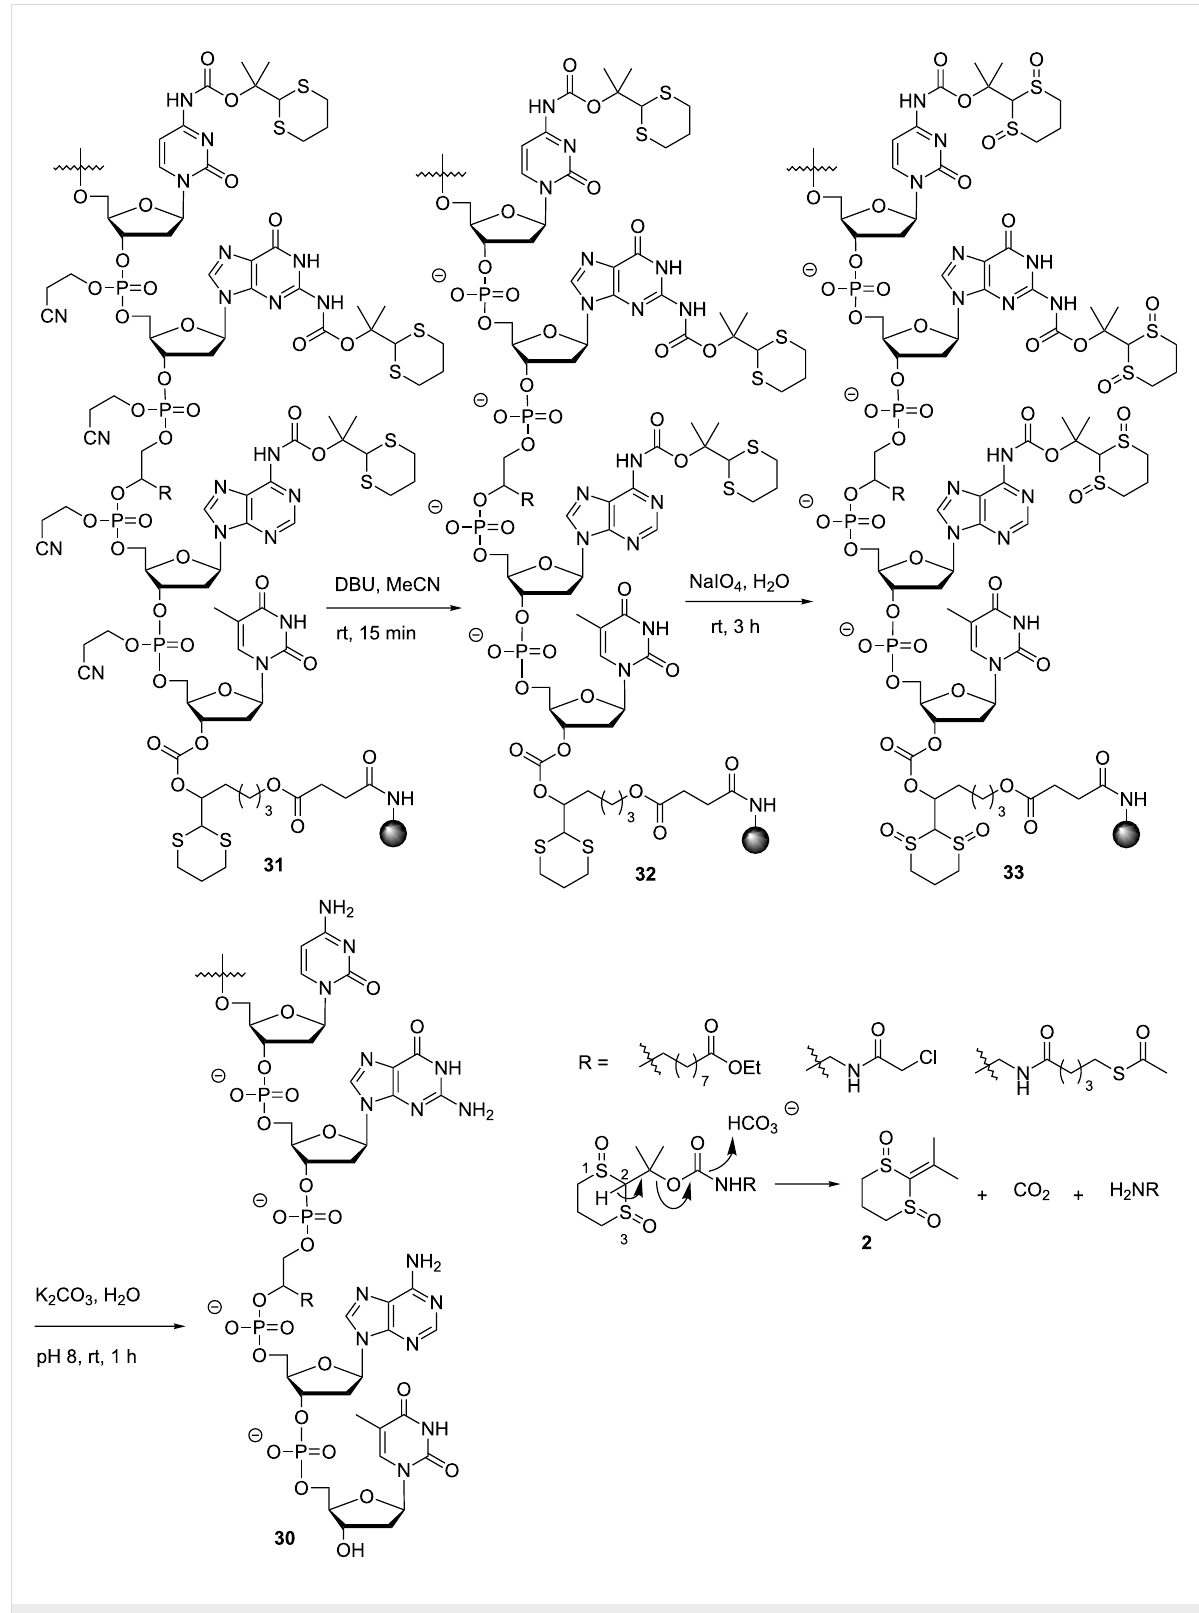
Scheme 4: ODN deprotection and cleavage under non-nucleophilic